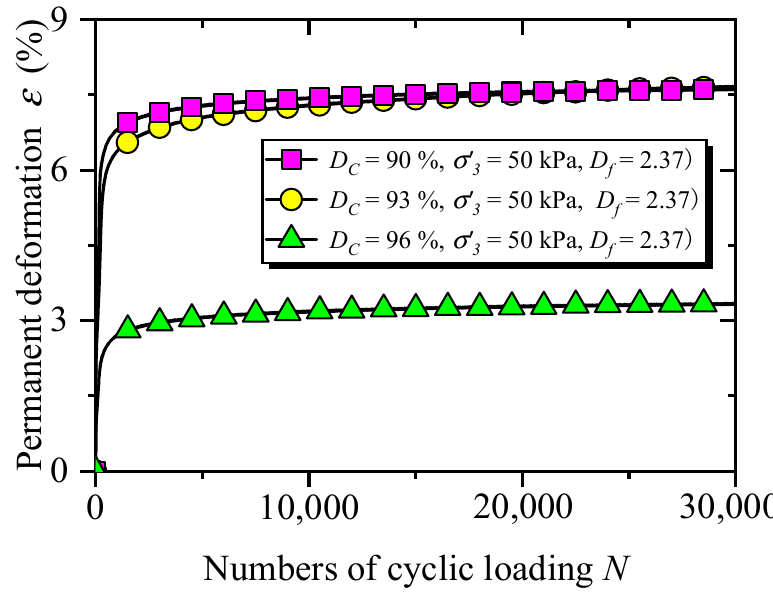
Figure 10. Evolution of 𝜀 versus N with di ff erent compaction degree values.